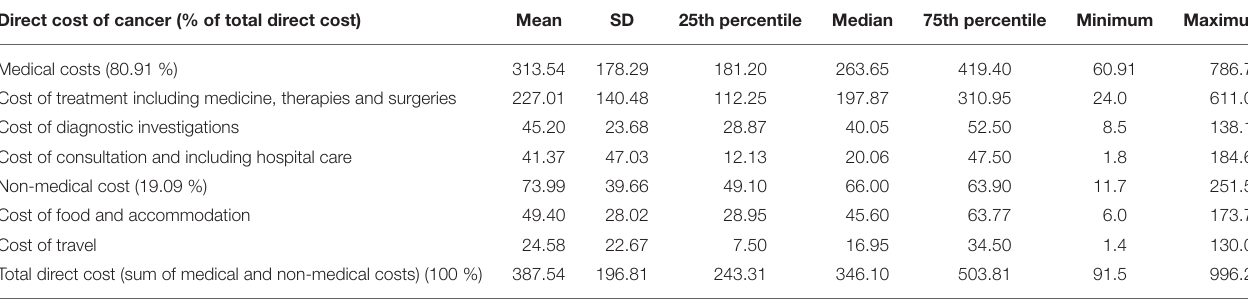
TABLE 3 | Total direct cost (NRs, ‘000) of cancer ( n =